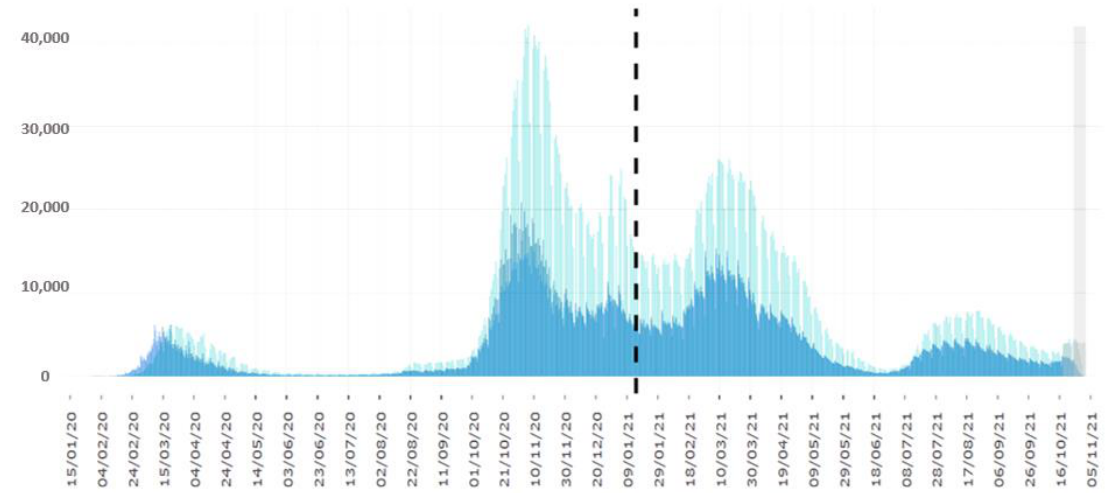
Figure 1. Distribution of COVID-19 cases in Italy between the years 2020 and 2021 (separed by the dotted line). Data are pdated at 2 November 2021 [4].